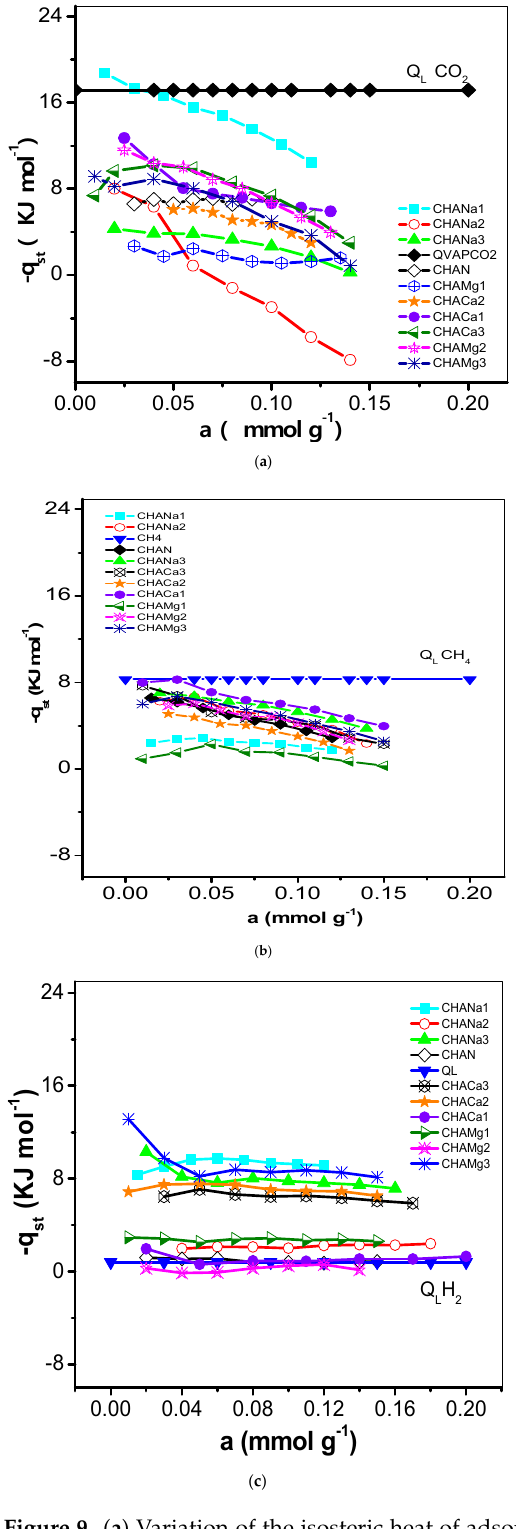
Figure 9. ( a ) Variation of the isosteric heat of adsorption ( − qst, kJ mol -1 ) of CO 2 with adsorbate loading on CHAN and exchanged CHA zeolites. ( b ) Variation of the isosteric heat of adsorption ( − qst, kJ mol -1 ) of CH 4 with adsorbate loading on CHAN and exchanged CHA zeolites. ( c ) Variation of the isosteric heat of adsorption ( − qst, kJ mol -1 ) of H 2 with adsorbate loading on CHAN and exchanged CHA zeolites.